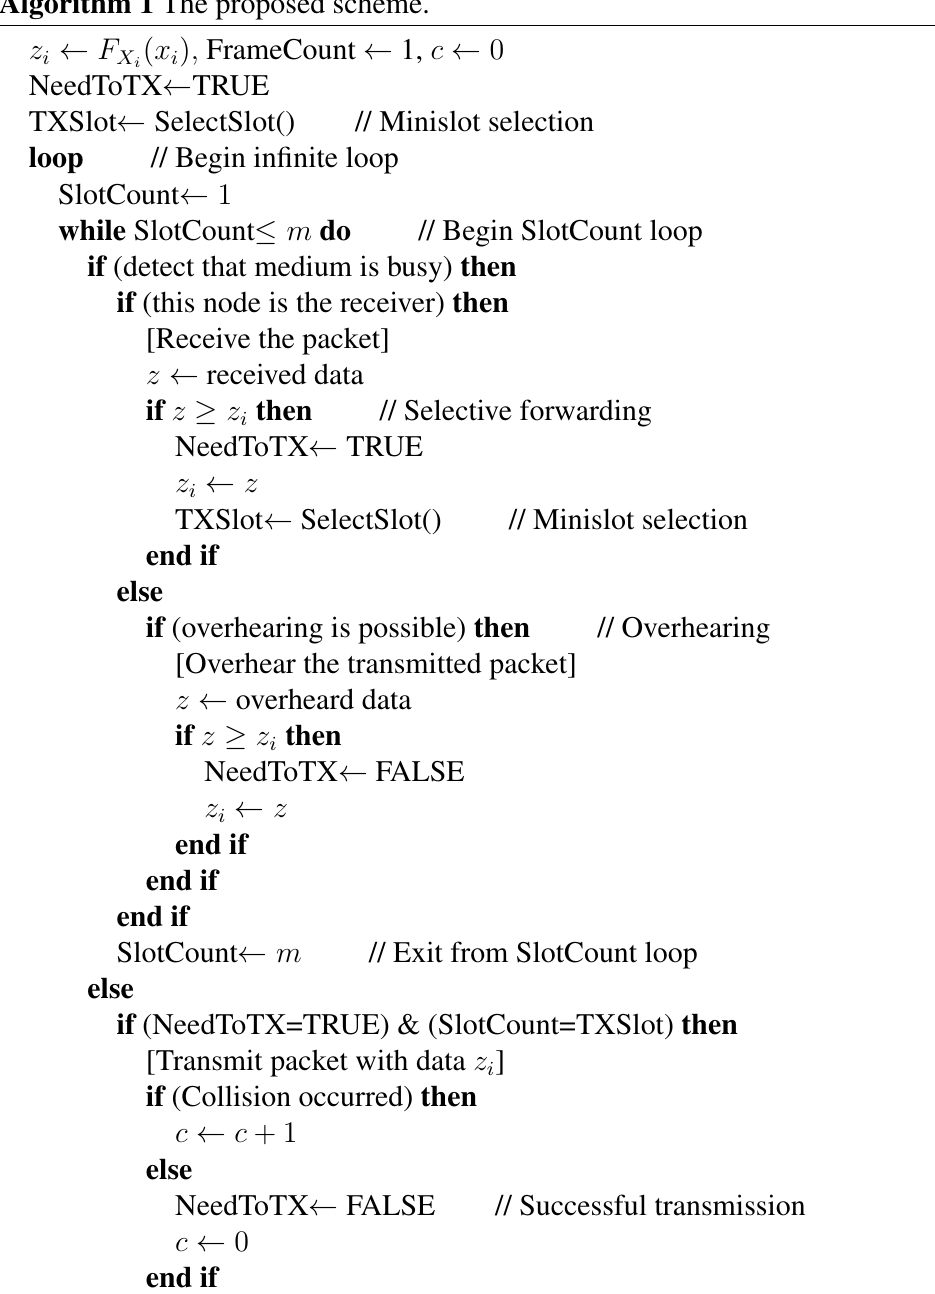
Algorithm 1 The proposed